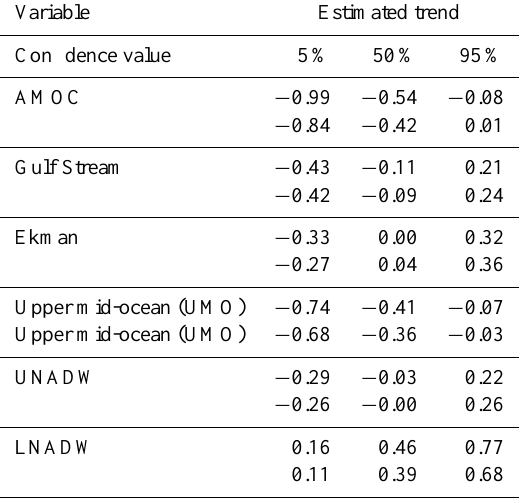
Table 3. Estimated trends for the AMOC at 26 ◦ N and its compo- nent parts. Two values are shown for each variable. The first (up- per) value includes the year starting in April 2009 and the second excludes 2009. Also shown are the 5 and 95 percentile values of the estimated trends. All values are Svyr − 1 . Positive implies increasing northward transport (or reducing southward transport). The number of degrees of freedom was set to 35 for the full time series and 31 when excluding data from 2009–2010.